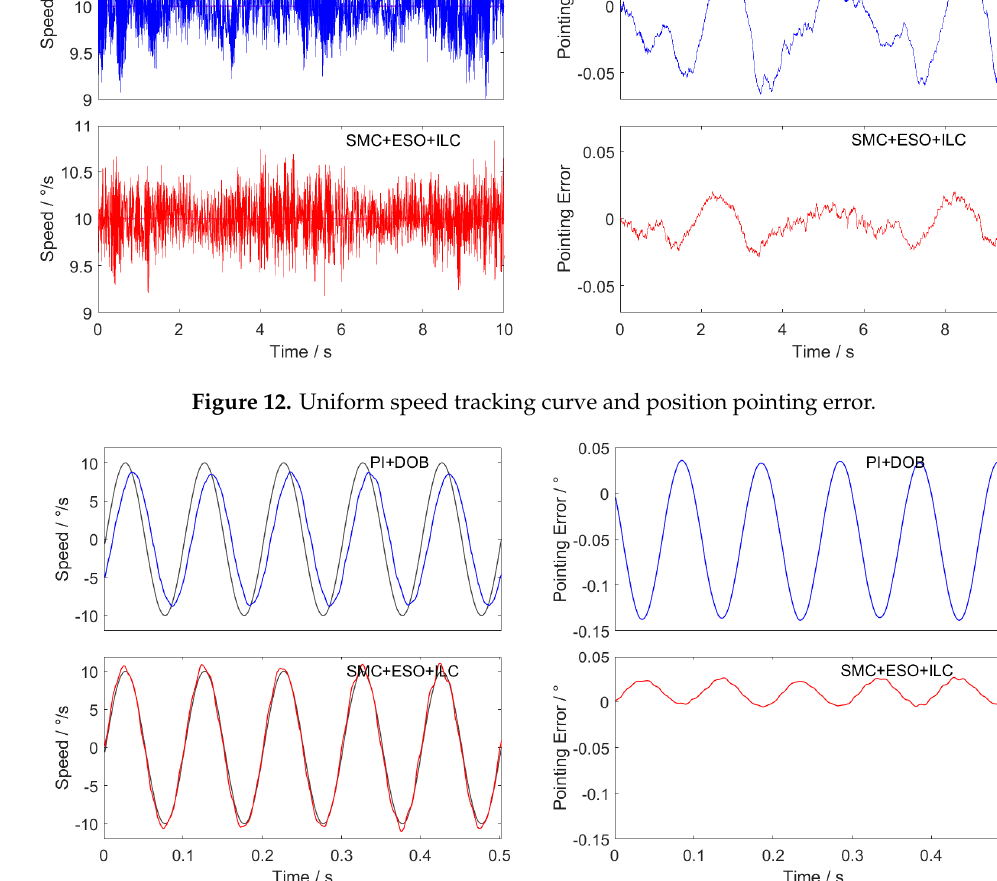
Figure 13. Sine wave tracking curve and position pointing error.